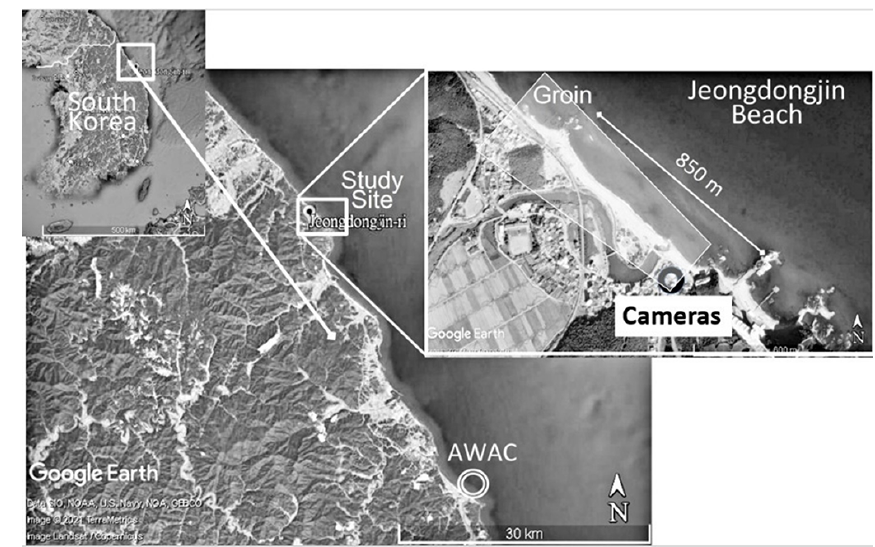
Figure 1. Location of Jeongdongjin Beach in Gangwon-do on the east coast of South Korea © Google Earth.